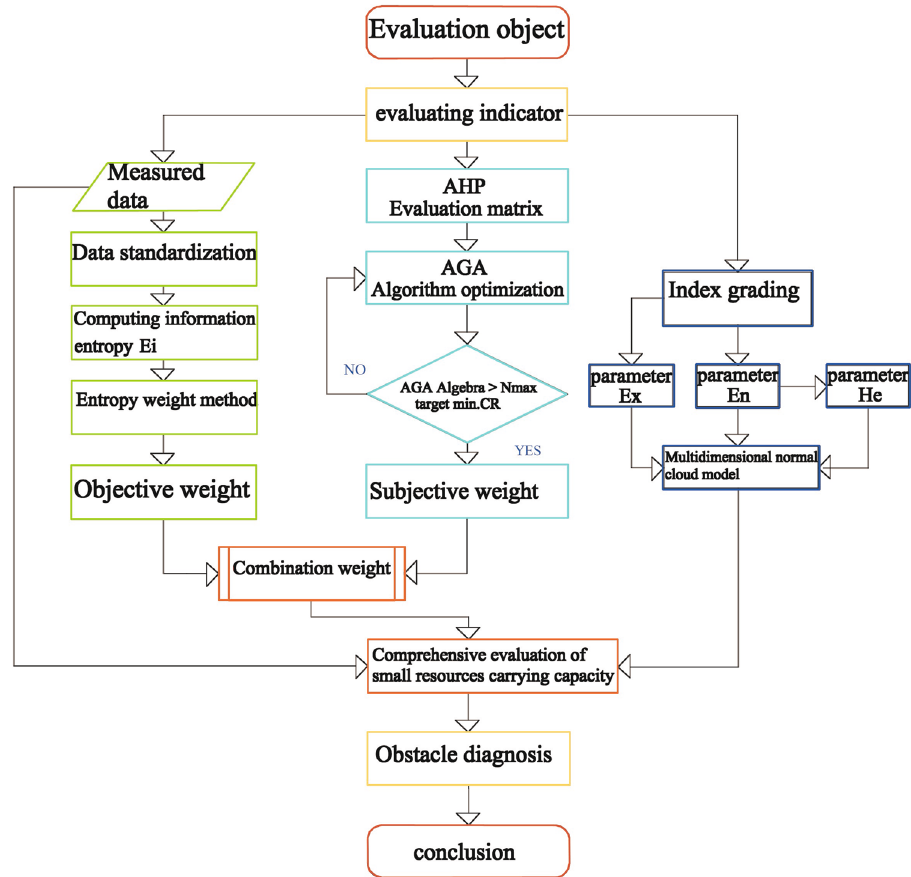
Fig. 1 The flowchart of water resources carrying capability evaluation based on